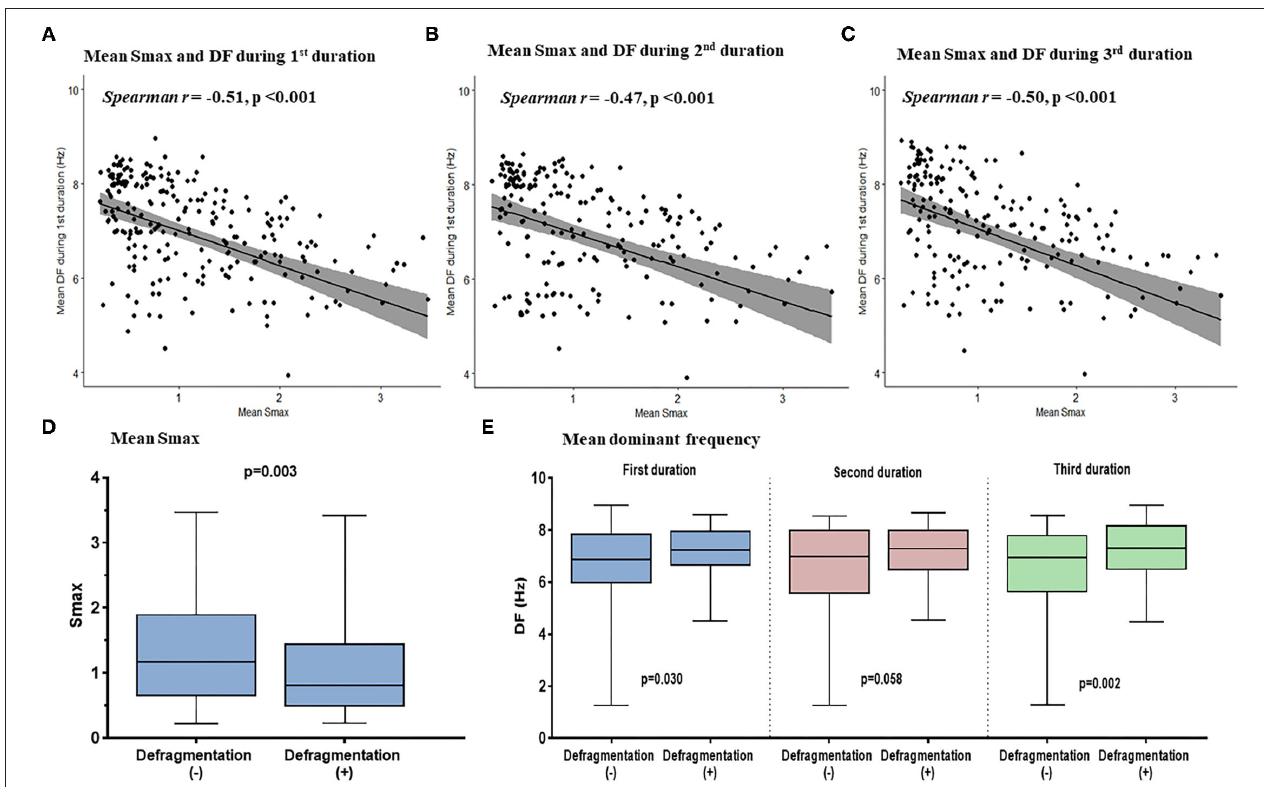
FIGURE 4 | The relationship between the Smax and DF in the computational simulation using 250 regions in 25 patients. The correlation between Smax and DF during 16–22s (A) , 22–28s (B) , and 28–34s (C) after virtual AF induction. Comparing the Smax (D) and the DF in three periods (E) according to AF defragmentation after virtual DF ablation. A point indicates Smax and DF in a single region of LA. Smax, the maximal slope of action potential restitution curve; DF, dominant frequency; AF, atrial fibrillation; LA, left atrium.